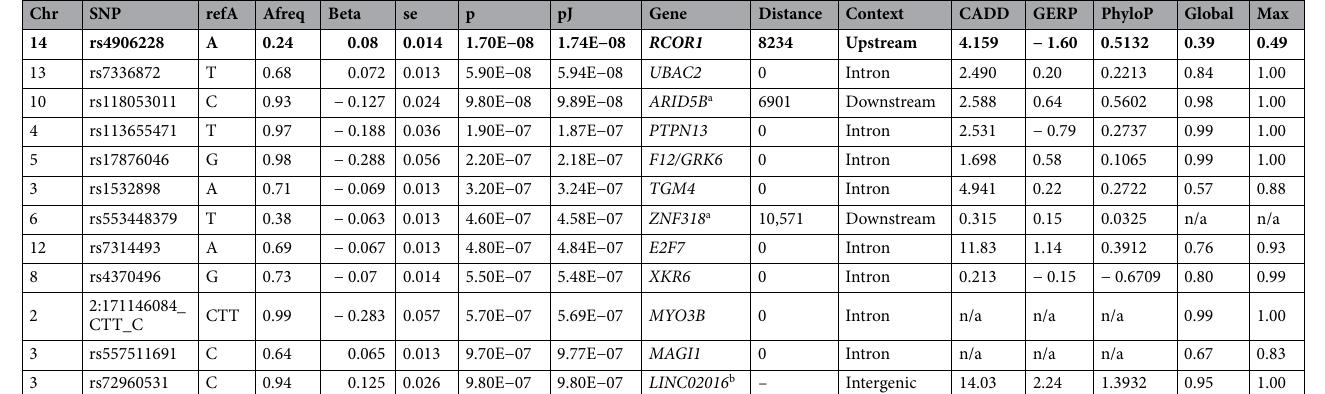
Table 3. Summary statistics for lead SNPs that reached a significance threshold of p < 1E−06, ordered by p value. Bold denotes genome-wide significance at p < 5E−08. Chr, chromosome; SNP, lead SNP; bp, base position; refA, reference allele; beta, effect size from BOLT-LMM approximation to infinitesimal mixed model; se, standard error of the beta; p-value, non-infinitesimal mixed model association test p-value, pJ, joint p-value for variation at loci calculated with GCTA-COJO; Gene, denotes the closest protein coding gene to the variant; Distance, is the distance from the gene (b.p.); Context denotes the consequence of the variant identified by VEP. a Denotes genes also identified in previous UKBB GWAS of self-reported hearing 22 . b rs72960531 is in an intergenic region without protein coding genes but is within an intron of the lincRNA LINC02016; Global, global effect allele frequency reported on Ensembl; Max, highest effect allele frequency reported in any group on Ensembl; n/a, data not